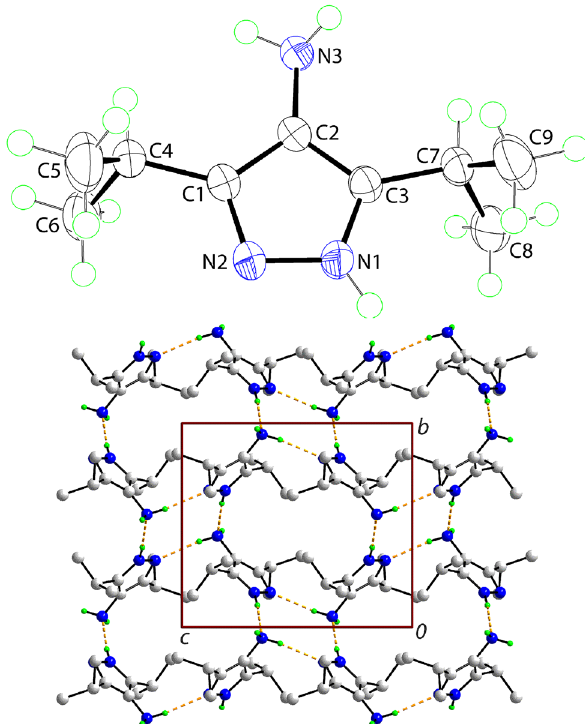
Table  : Data collection and